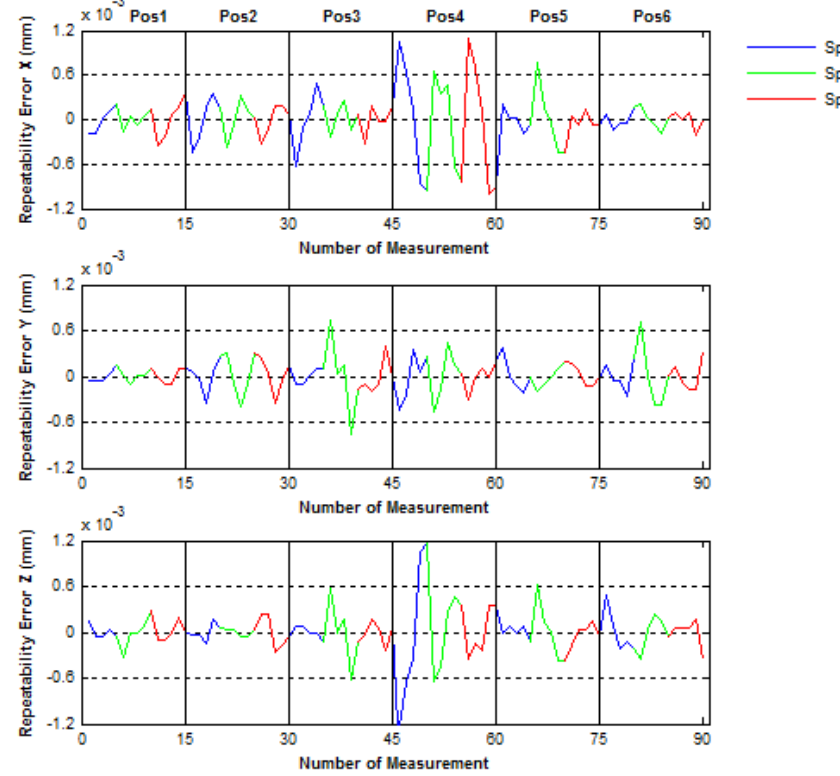
Figure 18. Positioning mechanical repeatability errors of the platform for the No-Continuous way.